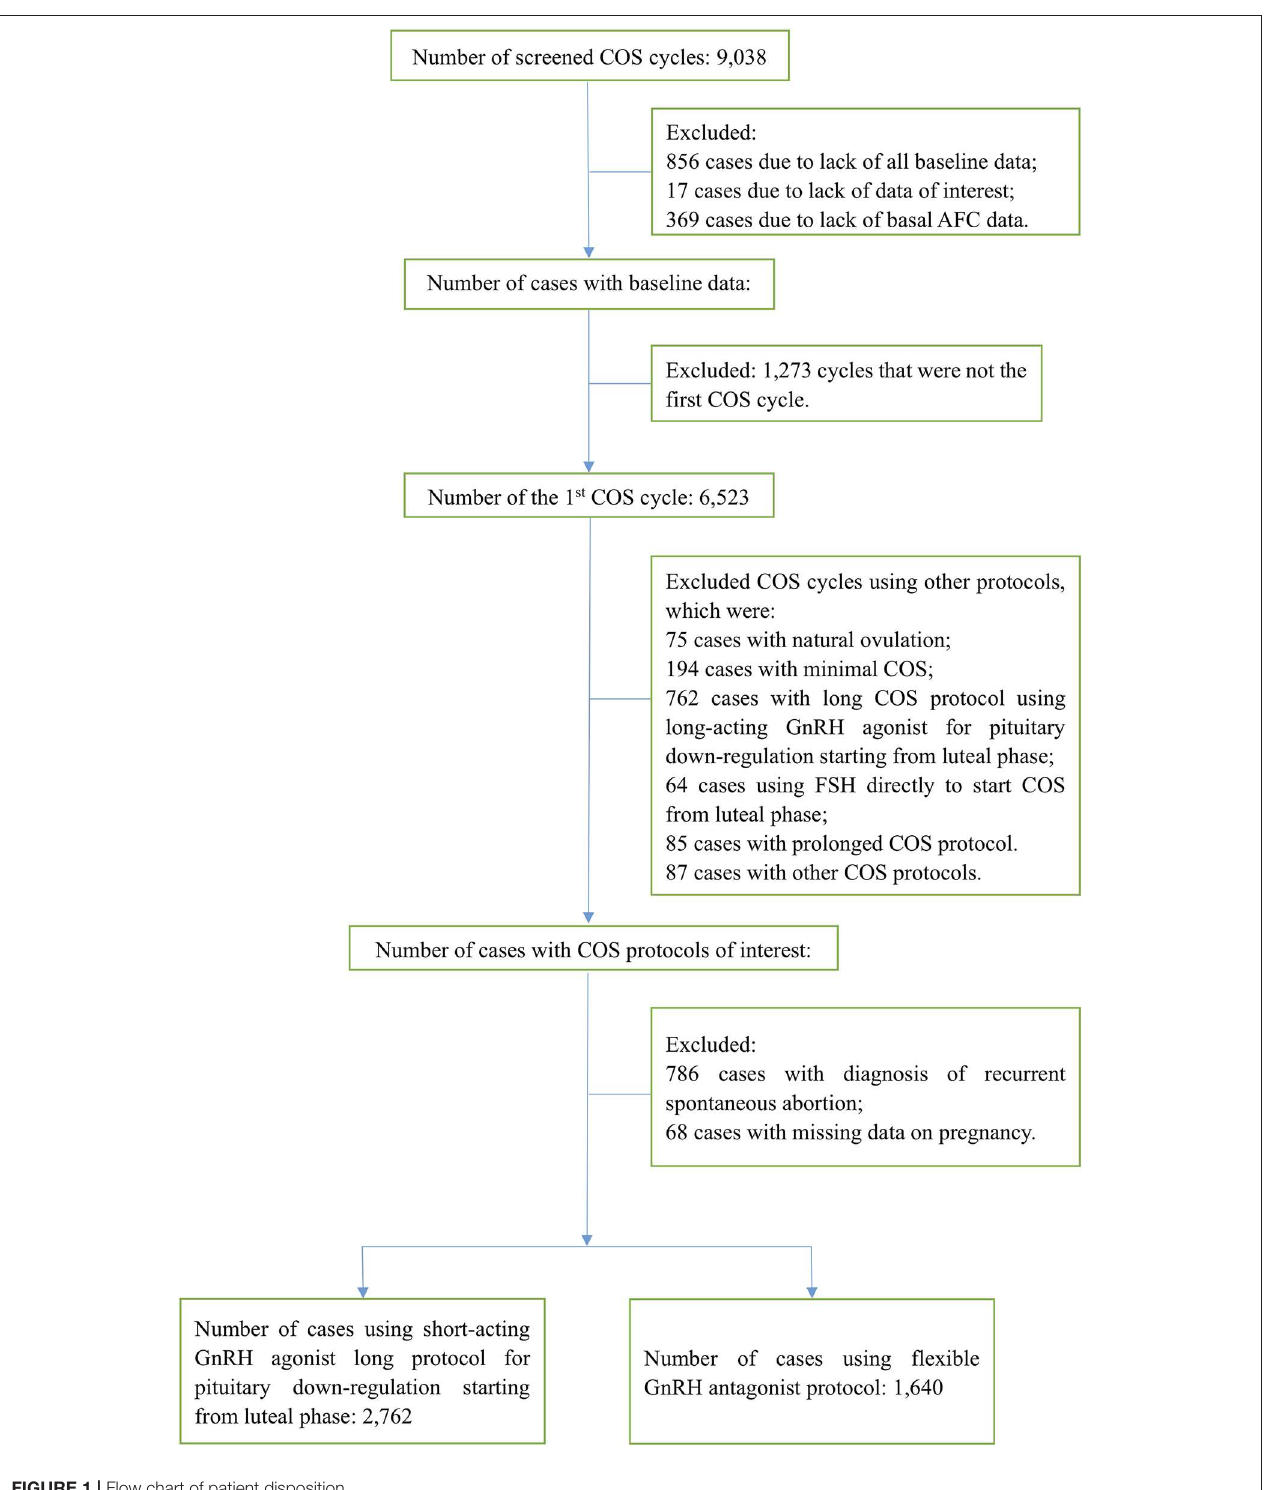
FIGURE 1 | Flow chart of patient disposition. patients underwent the fresh embryo transfer cycle in GnRH agonist and antagonist group, respectively, and the difference was not statistically significant. The number of patients underwent